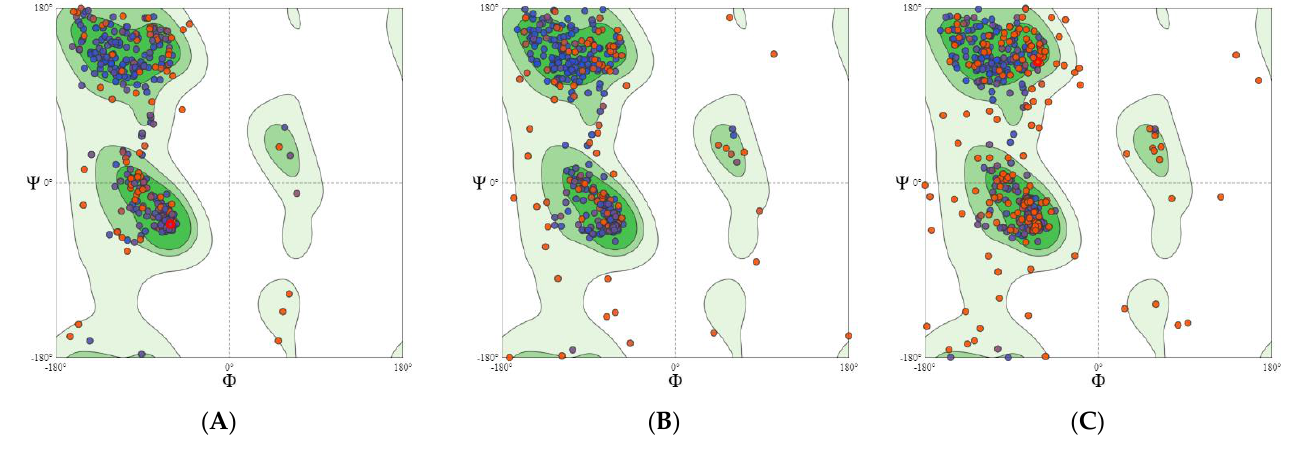
Figure 2. The optimized model of human GABA receptors ( A ) α5 , ( B ) β1, and ( C )